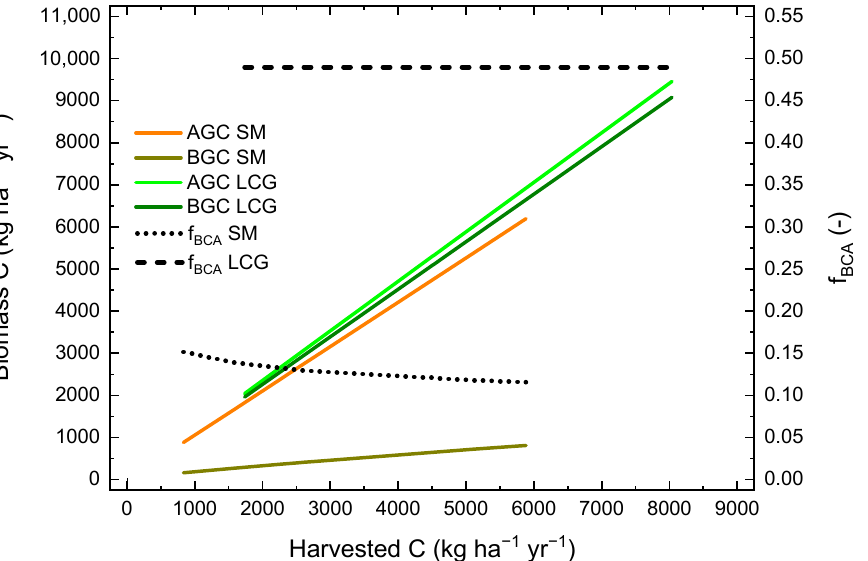
Figure 5. Relationships between modelled carbon in above ‐ (AGC) and belowground biomass in topsoil (0–30 cm) and subsoil (30–60 cm) (BGC), as well as the fraction of carbon that is allocated belowground (f BCA ) and the carbon in harvested biomass for the two crops silage maize (SM) and lucerne ‐ clover ‐ grass (LCG) over the range of measured crop ‐ specific yields.